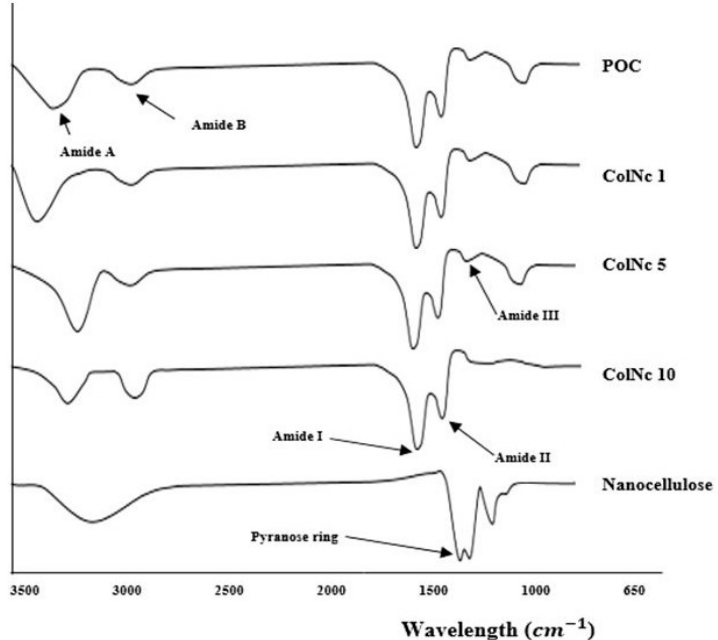
Figure 4. The chemical structure of fabricated bioscaffolds via FTIR. The various absorbance peaks represented by different chemical structure including amide A, amide B, amide I, II and III.